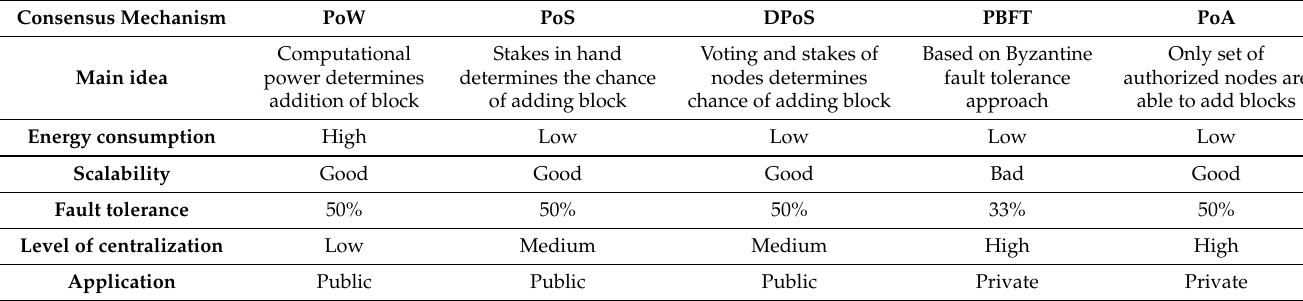
Table 3. Comparison of different consensus